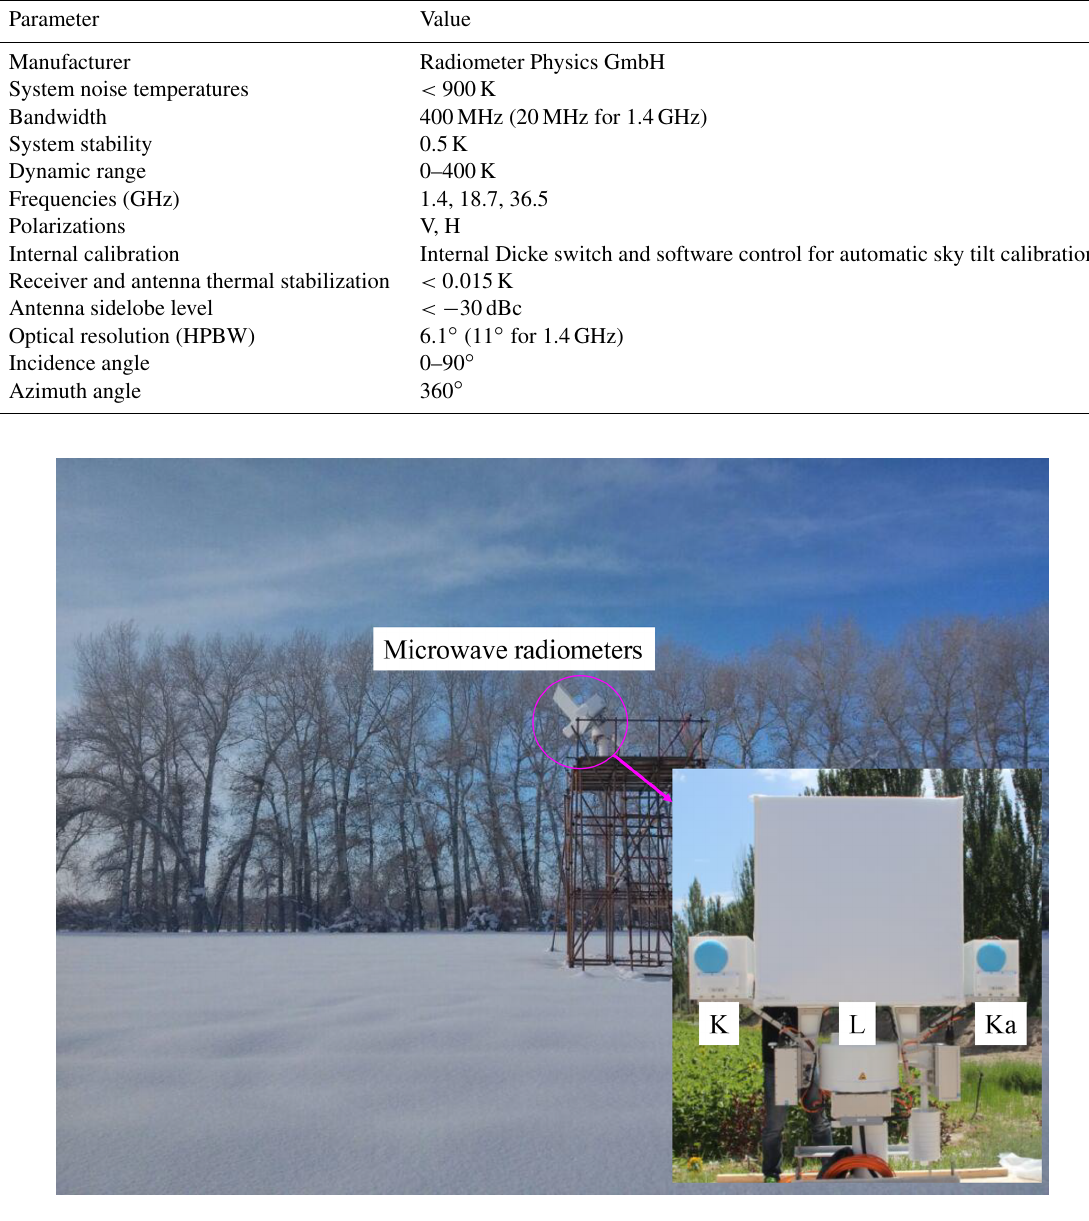
Figure 2. Ground-based microwave radiometer observation